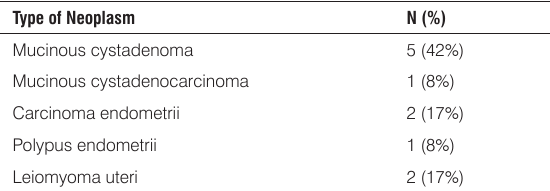
Table 2. Neoplasms Associated With Brenner Tumors.